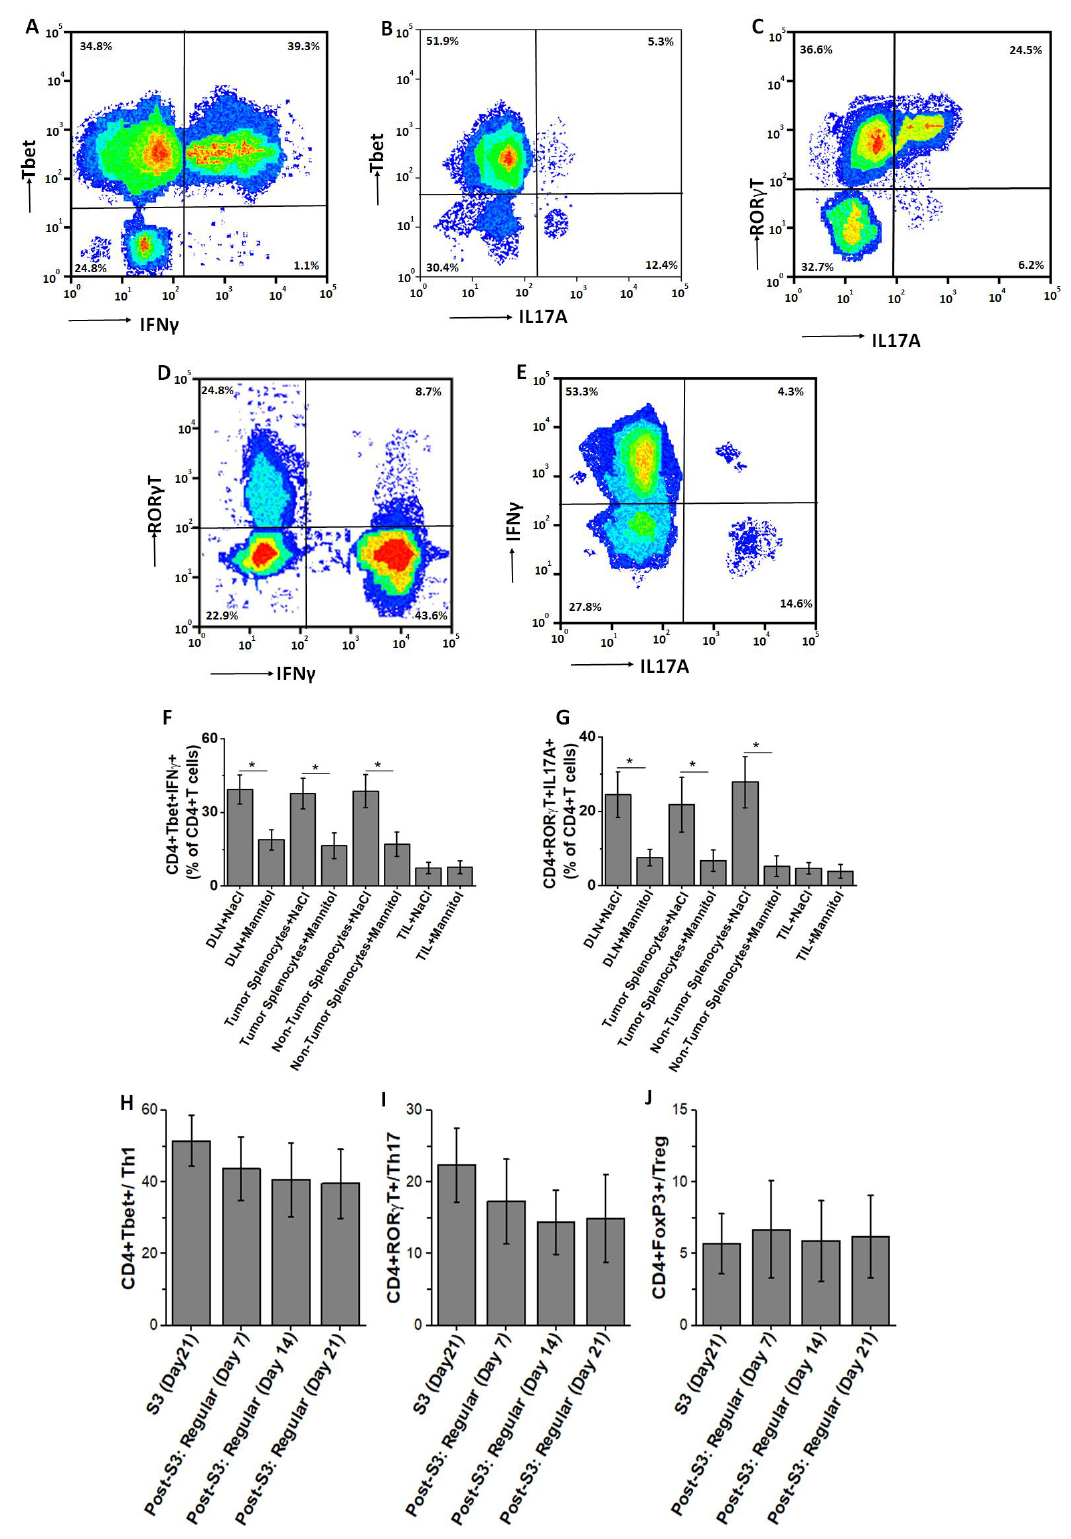
Figure 3. Intracellular cytokine expression in ex vivo expanded CD4+T cells at the end of third high salt stimulation. The ex vivo expanded CD4+T cells were stained for Tbet, IFN γ , ROR γ T and IL-17A. ( A – E ) CD4+T cells obtained from DLNs were stained at the end of third stimulation and following plots were reported: ( A ) Cells stained for Tbet and IFN γ ; ( B ) Cells stained for Tbet and IL-17A; ( C ) Cells stained for ROR γ T and IL-17A; ( D ) Cells stained for ROR γ T and IFN γ ; ( E